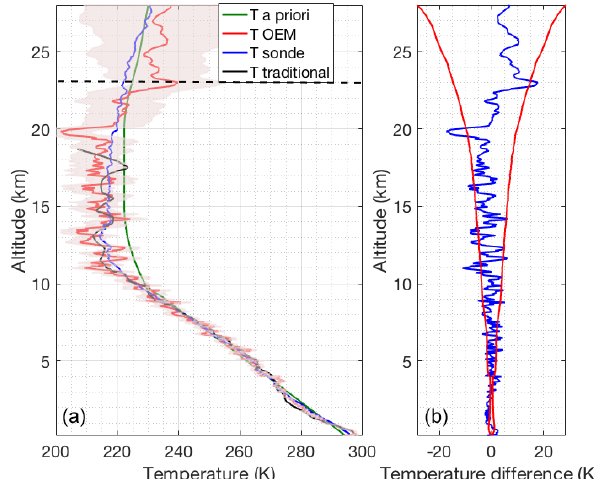
Figure 15. Same as Fig. 4 but for 5 July 2011 with a cirrus cloud at 6km height, using the